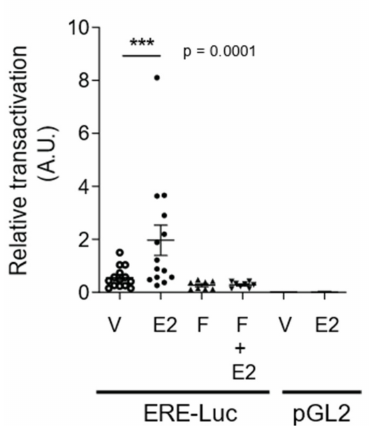
Figure 2. E2 induces transactivation of ERs in hGCs. Cells were transiently transfected with Firefly luciferase reporter plasmid containing or not (pGL2) estrogen-response elements (EREs) upstream of luciferase (ERE-Luc). An internal control vector containing Renilla luciferase was also included. Twenty-four hours post-transfection, cells were treated with either solvent vehicle (V) or 10 nM E2, in the presence or absence of 1 µ M Fulvestrant (F), an ER degrader (SERD). Twenty-four hours later, cells were lysed and analyzed for luciferase activity. Firefly luciferase activity was normalized relative to Renilla luciferase activity, reported as relative transactivation activities arbitrarily set at 1 for the solvent vehicle (V) condition in ERE-Luc-transfected cells. Each point represents the mean ± SEM of 14 experiments (from each patient) performed in six replicates. *** p ≤ 0.001 vs. solvent vehicle (V) by two sides Wilcoxon signed-ranks test. A.U., Arbitrary